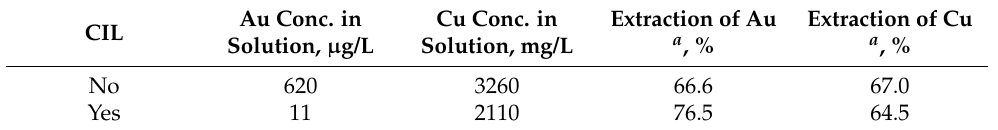
Table 5. Effect of carbon addition on metals extraction at 48 h (20 g/L glycine, 10 kg/t KMnO 4 (stg. addit.), with a pH level of 10.5, with 30% solids, at 30 ◦ C; 20 g/L carbon added at 24 h for the CIL test). Au Conc. in Cu Conc. in Extraction of Au Extraction of Cu CIL a , % a , % Solution, µ g/L Solution, mg/L No 620 3260 Yes 11